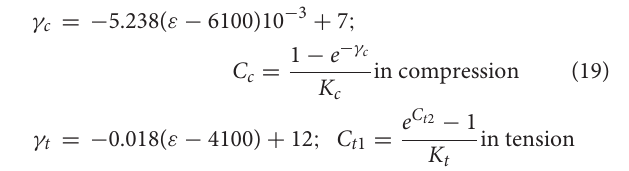
where N is the number of cycles and C t 2 = − 20 was fitted from the experimental curves along with: